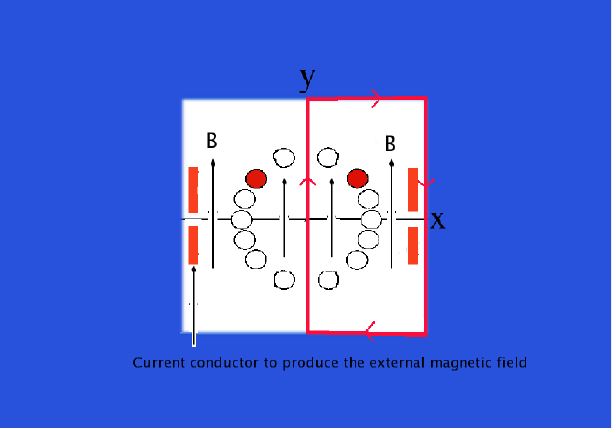
FIG. 7. The schematic picture of the i th Cu stripe in terms of the electric circuit theory. The character C denotes the capacitor associated on the Cu stripe, R does the resistance of Cu stripe, L is the mutual inductance between the i th and the j th coil, and ij L is the self-inductance of the i th coil. ii